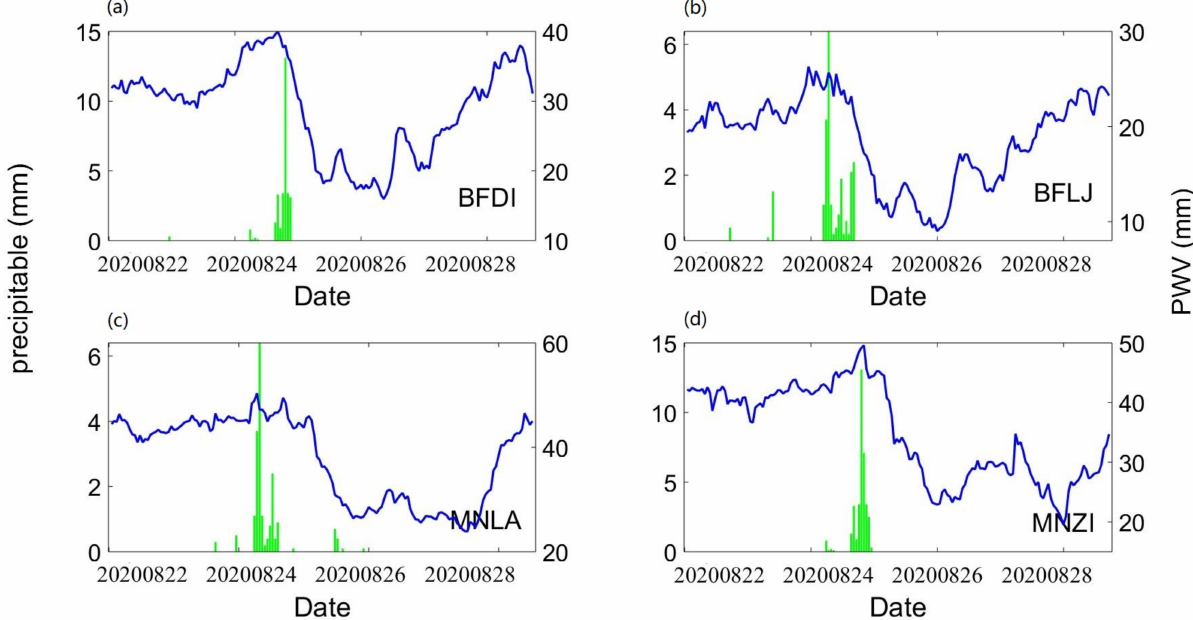
Figure 13. The precipitation and the PWV at stations from 22 August to 28 August 2020 (blue curve: the PWV, unit: mm; green column: the precipitation, unit mm. ( a ) BFDI, ( b ) BFLJ, ( c ) MNLA, ( d )